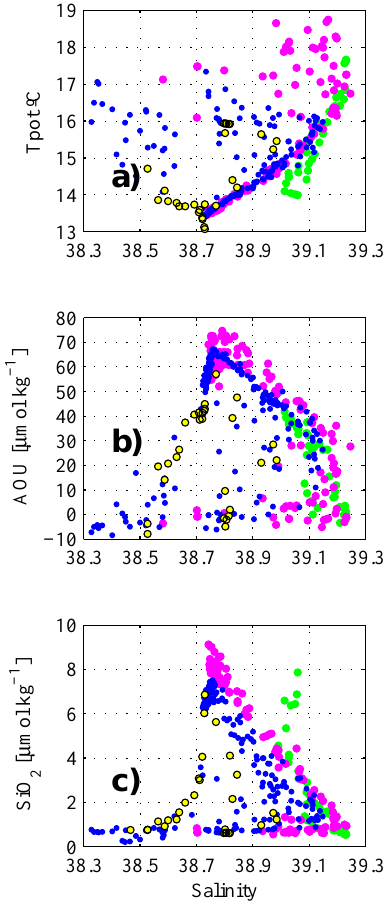
Fig. 11. Property-property plots for the M84/3 data in the eastern plots for the M84/3 data in the eastern basin: Aegean Sea (green Fig. 11. Property–property basin: Aegean Sea (green dots), Levantine basin (magenta), Ionian dots), Levantine basin (magenta), Ionian Sea (blue) and Adriatic Sea (yellow). (a) Potential Sea (blue) and Adriatic Sea (yellow). (a) Potential temperature ( ◦ C) vs. salinity, (b) Apparent Oxygen Utilisation (AOU in µmolkg − 1 ) temperature ( ◦ C) vs. salinity, (b) Apparent Oxygen Utilization (AOU in µmolkg − 1 ) vs. salinity vs. salinity and ( C ) silicate concentration (SiO 2 in µmolkg − 1 ) vs. salinity. The station positions are shown in Fig. and (c) silicate concentration (SiO in µmolkg − 1 ) vs. salinity. The station positions are shown in 2 Fig. 1.